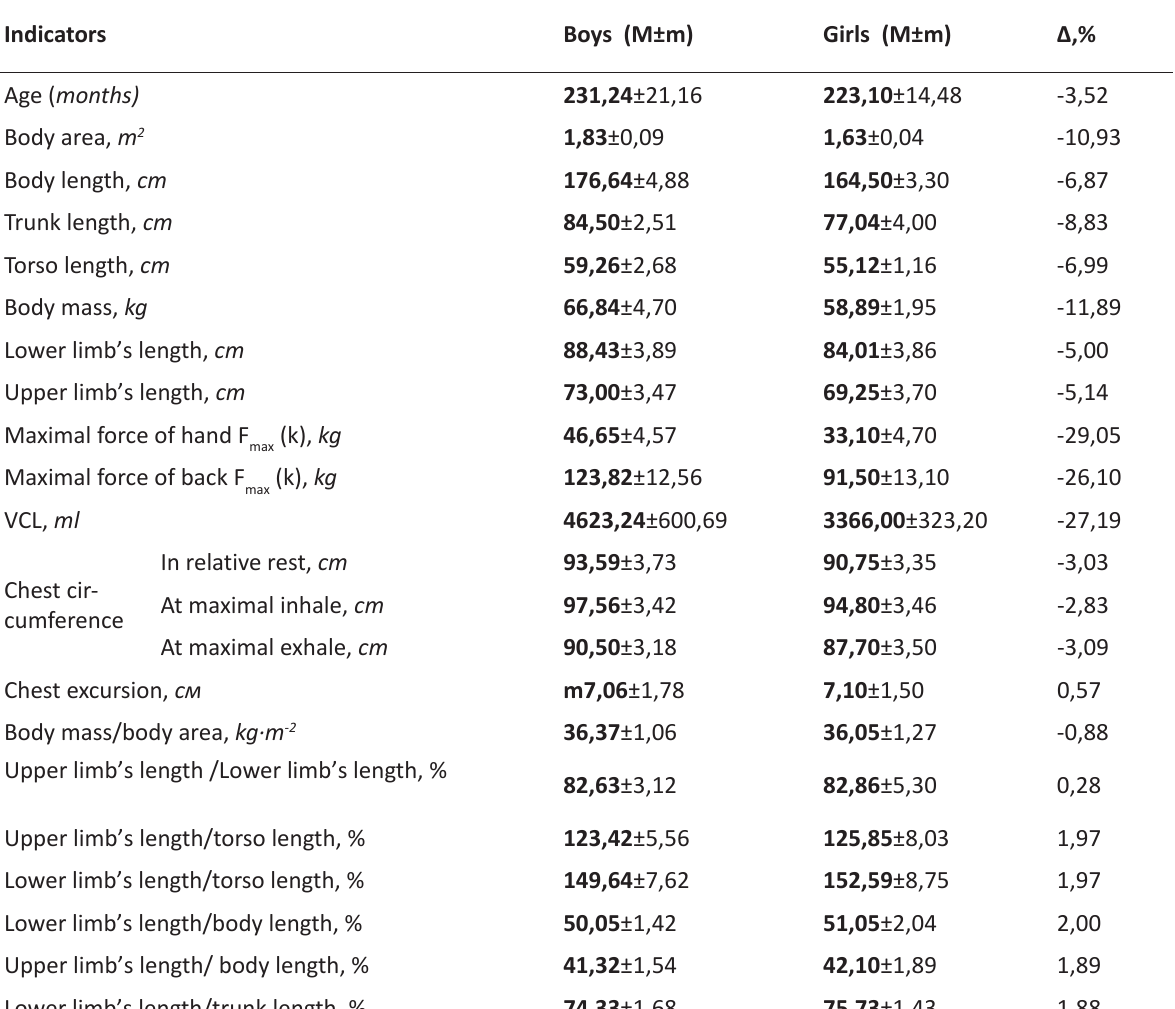
Table 1. Somatologic indicators of students – members of biathlon sport-pedagogic perfection group